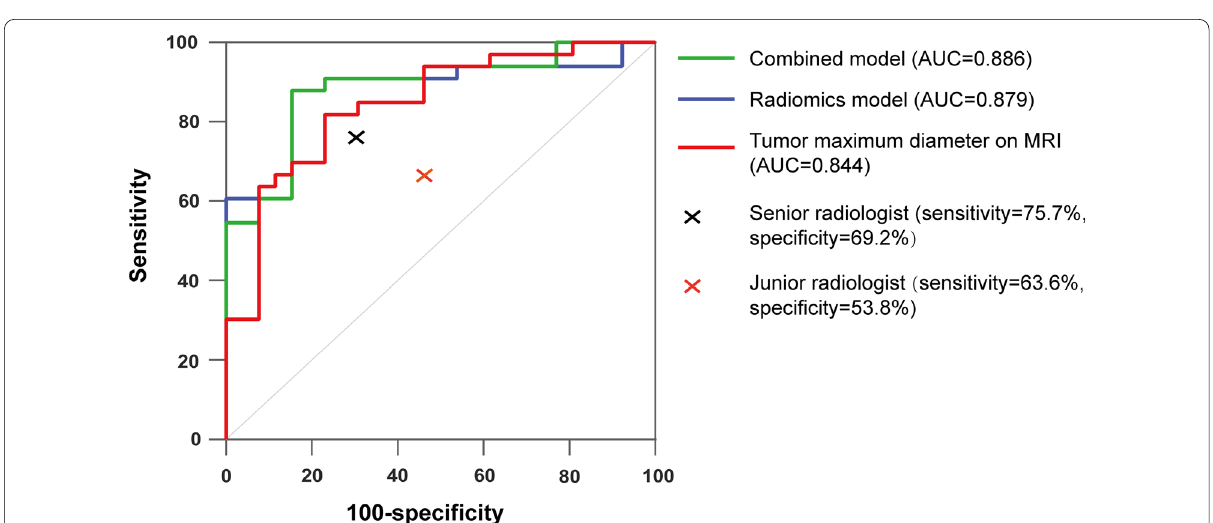
AUC, Area Under the Curve; SEN, sensitivity; SPE, specificity; PPV, positive predictive value; NPV, negative predictive value; MTD, maximal tumor diameter